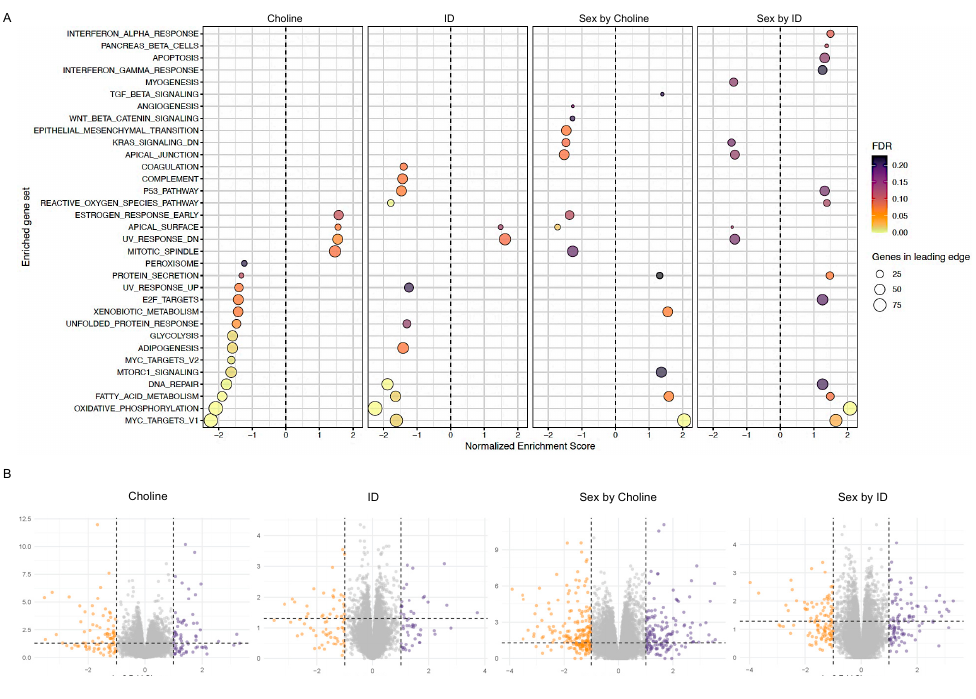
Figure 5. An alternative approach using ranked gene lists. ( A ) GSEA analysis using sex-combined datasets showing the effects of choline supplementation, ID, and their interaction with sex on en ‐ riched gene sets. Tests were made using males, IS, and non ‐ choline ‐ supplemented diets as a base ‐ line. ( B ) Volcano plots showing genes with significant p ‐ value (<0.05).